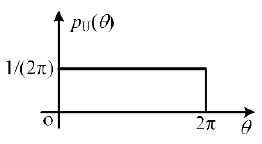
Figure 13. The uniform distribution of the multi-radiator phase.